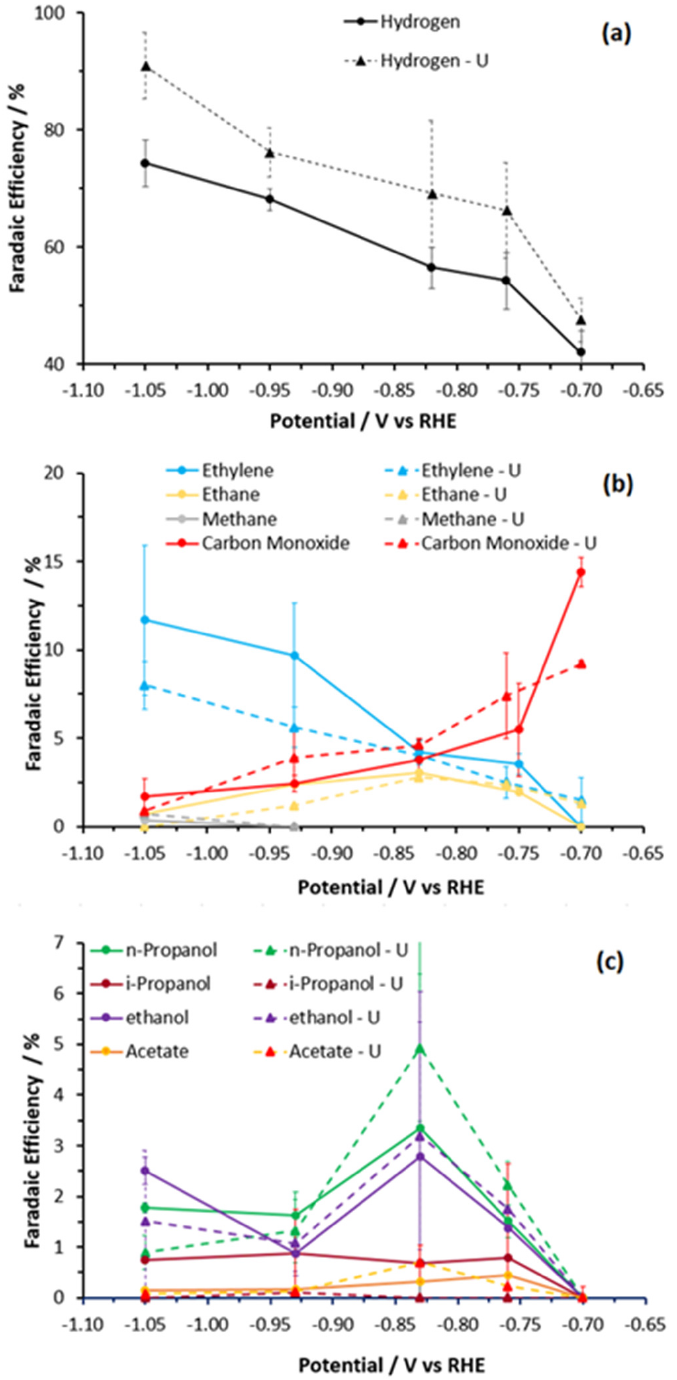
Figure 7. Faradaic efficiencies of ( a ) hydrogen ( b ) carbon-based gas products and ( c ) liquid products versus potential, corrected to RHE, for copper foams CF-18H (solid lines) and CF-18H-100U (dashed lines). Data for formate are provided in SI Figure S7.